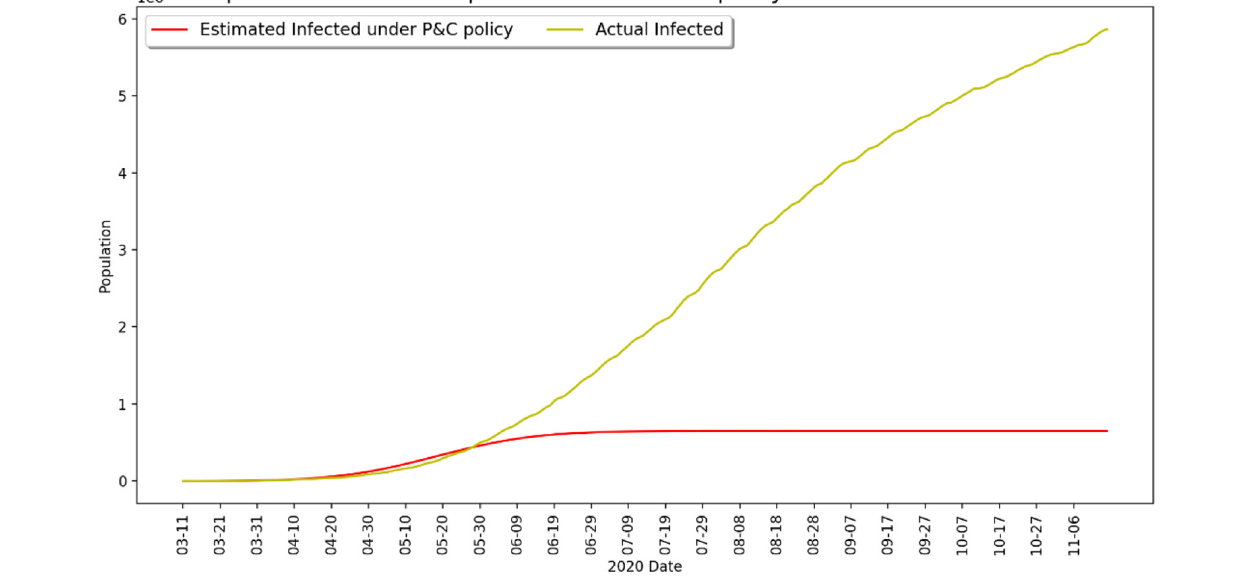
FIGURE 5 | Infected number under strict P&C and actual situation in Brazil.